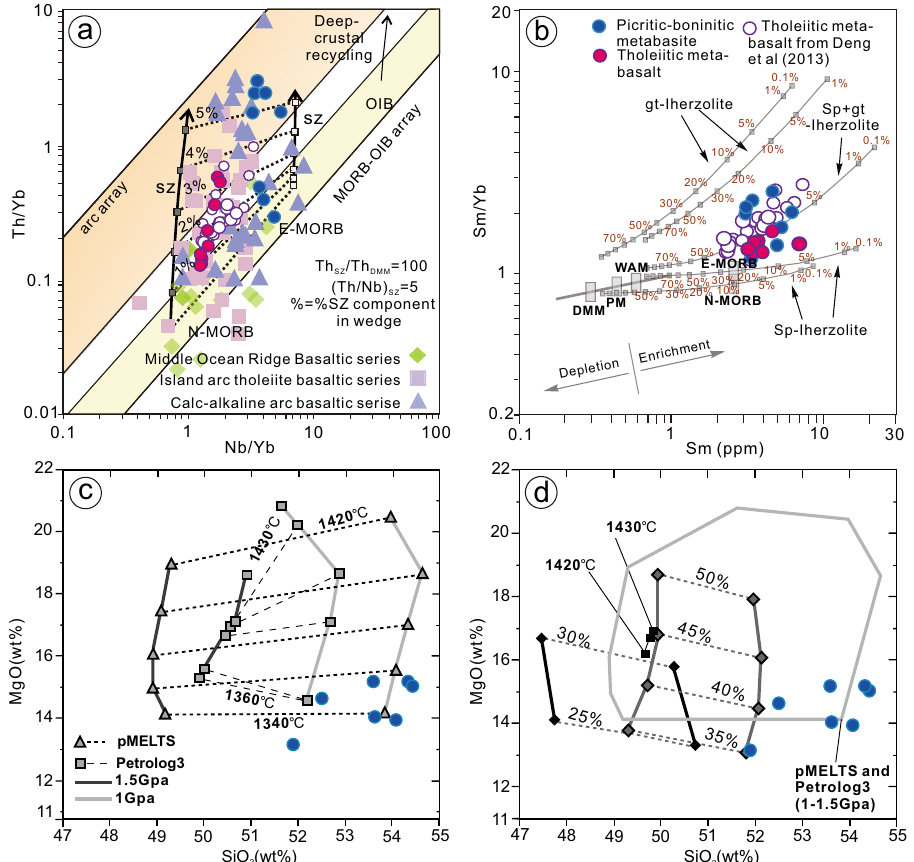
Fig. 8 Petrogenesis discriminant diagrams of the Zanhuang picritic-boninitic-tholeiitic series rocks. a Th/Yb versus Nb/Yb, tectonic discriminant diagrams 38 for the metabasaltic samples. Picritic-boninitic series are represented by blue circles whereas tholeiitic basalts are represented by red circles; the MORB-IAT-CAB data are collected from Fuxin-Chaoyang terrane, western Liaoning 61,62 ; Shaheqiao-Qinglong-Shangying terrane, eastern Hebei 63 – 65 ; Zanhuang complex 26 ; Sanhuangzai domain in Dengfeng complex 66 . b Plots of Sm/Yb vs Sm diagram 67 , on which melt curves correspond to degrees of partial melting for a given mantle source by the non-modal batch melting equations 68 . PM (Primitive Mantle), N-MORB (Normal Middle Ocean Ridge Basalt), E-MORB (Enriched Middle Ocean Ridge Basalt), and WAM (Western Anatolian Mantle). c , d Results of experimental studies along with melting parameterizations by Bénard et al. 34 , where they produced picritic to boninitic melts with compositions similar to ours (Supplementary data 2). Our data is plotted with blue symbols, along the extensions of the temperature and melt percentages from Bernard et al. ’ s experiments 34 , and from this, we infer that our samples formed under conditions of 20 – 45% melting of the refractory hybrid mantle wedge at 1340 – 1360 °C, with 1.4 – 3.3% water. One anomalous sample was discounted due to the deviation from the main plotting fi diagram 41 (Fig. 9), which denotes their similarity with island-arc